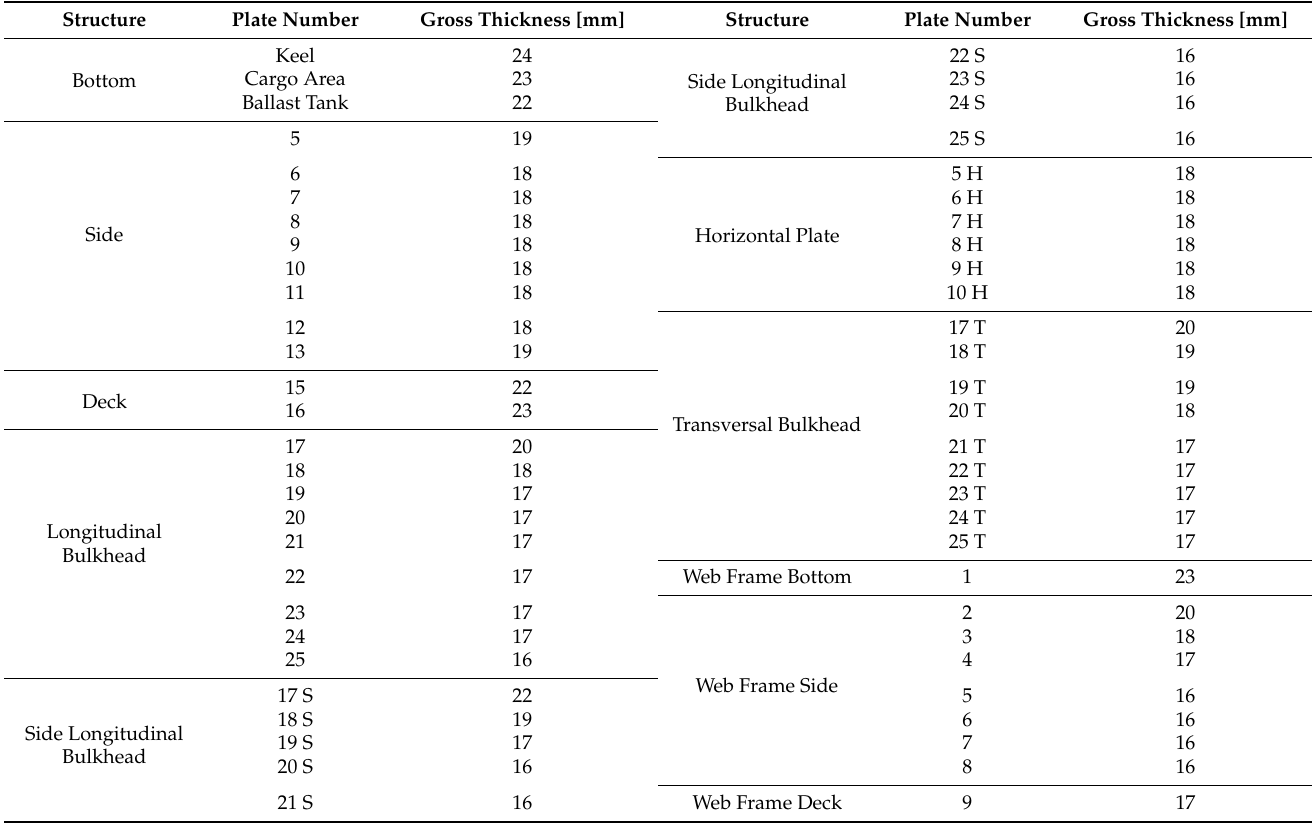
Table 2. Gross thickness obtained after the design based on the FPI guidelines